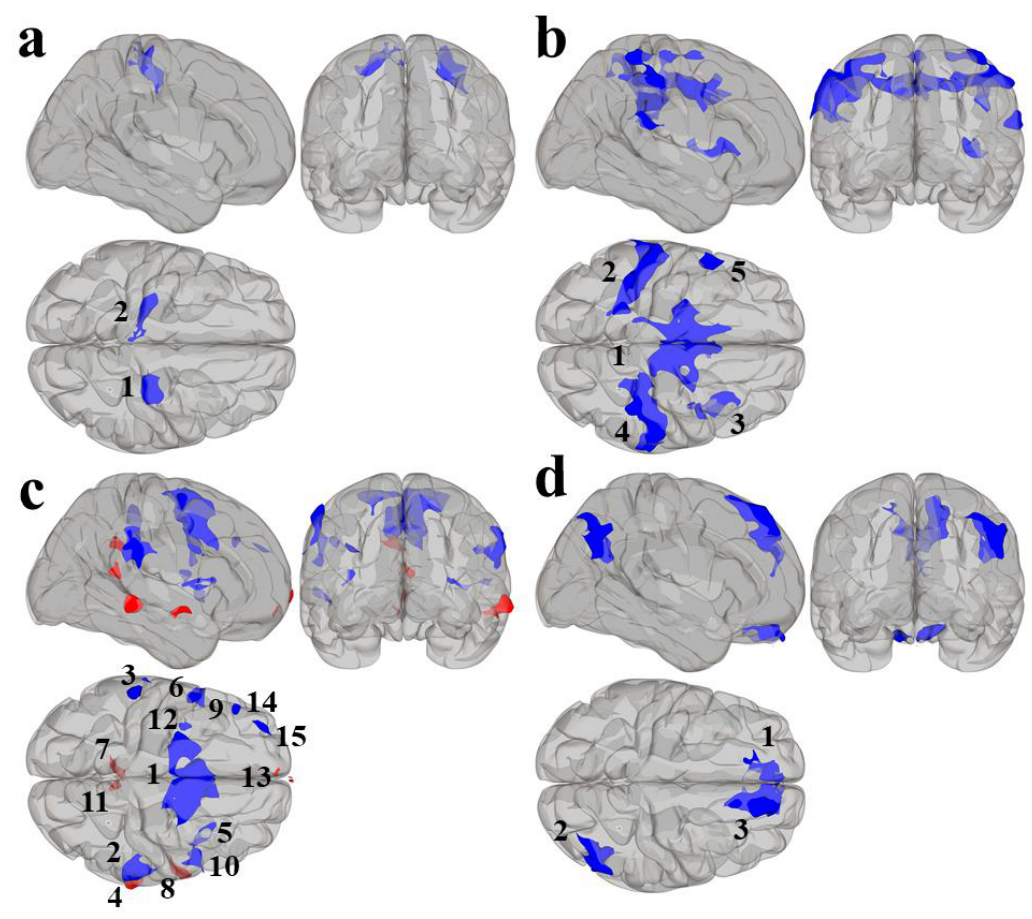
Figure 2. Results from the second-level seed-to-voxel RsFc analysis for MVPA Clusters ( a – d ). Red refers to positive associations and blue refers to negative associations. The numbers refer to the specific cluster within each MVPA cluster.